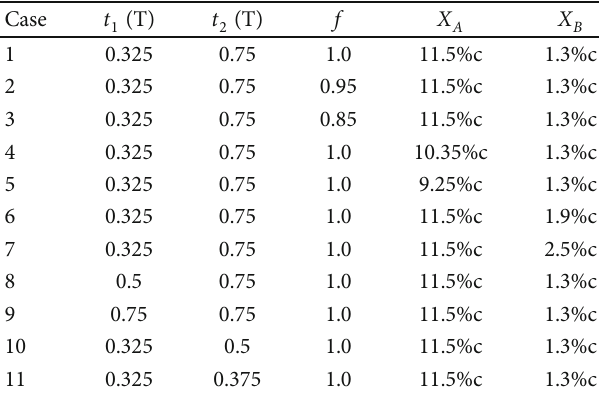
Figure 9: Control laws of in fl ation and de fl ation during a pitching cycle. Table 1: Details of the control law and structural arrangement parameters.